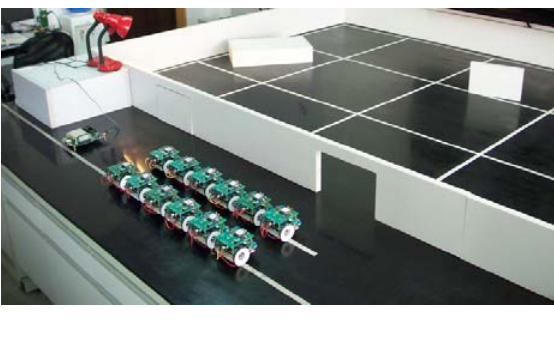
Figure 8. Testbed setup for the experiments on the mobile sensor